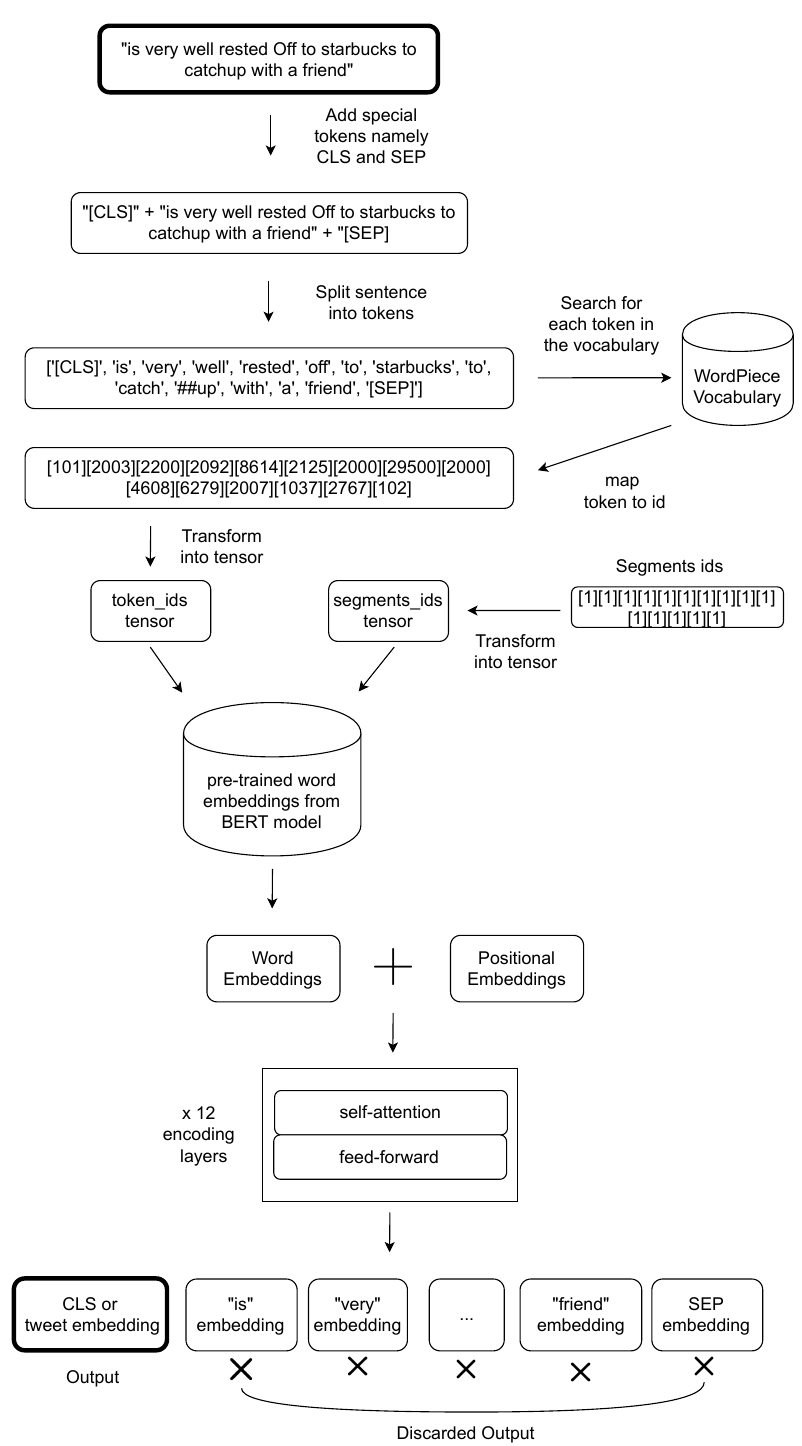
Figure 3. Tokenization and encoding with the transformer. Each tweet in the CoAID extended dataset is processed as shown in the figure. We added a CLS token (classification task special token) at